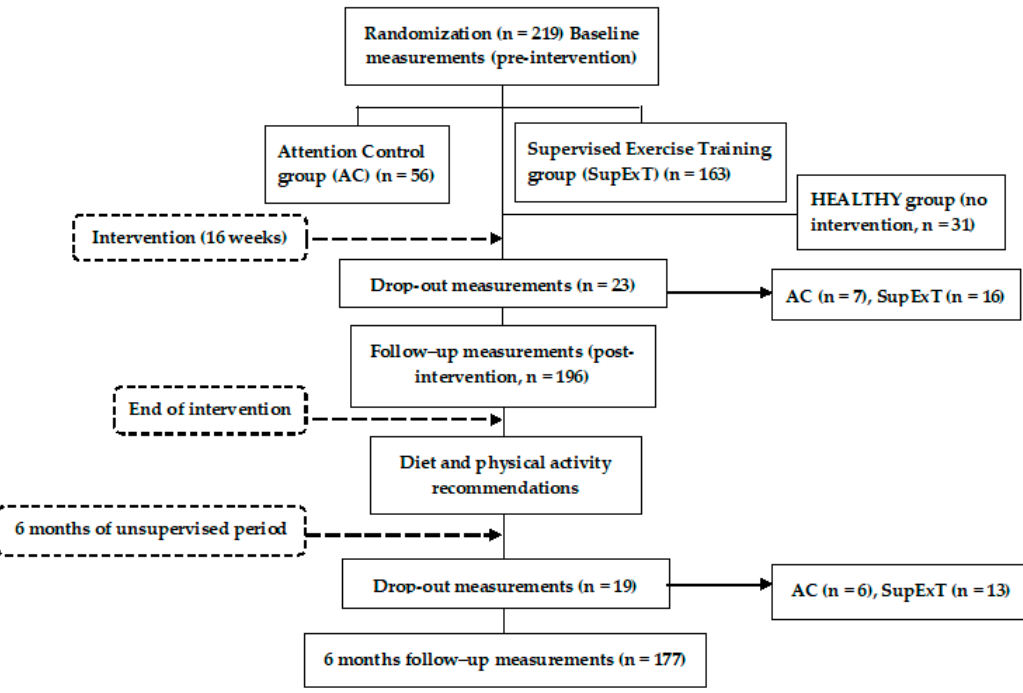
Figure 1. Flow diagram of the EXERDIET-HTA study from recruitment to the 6-month unsupervised